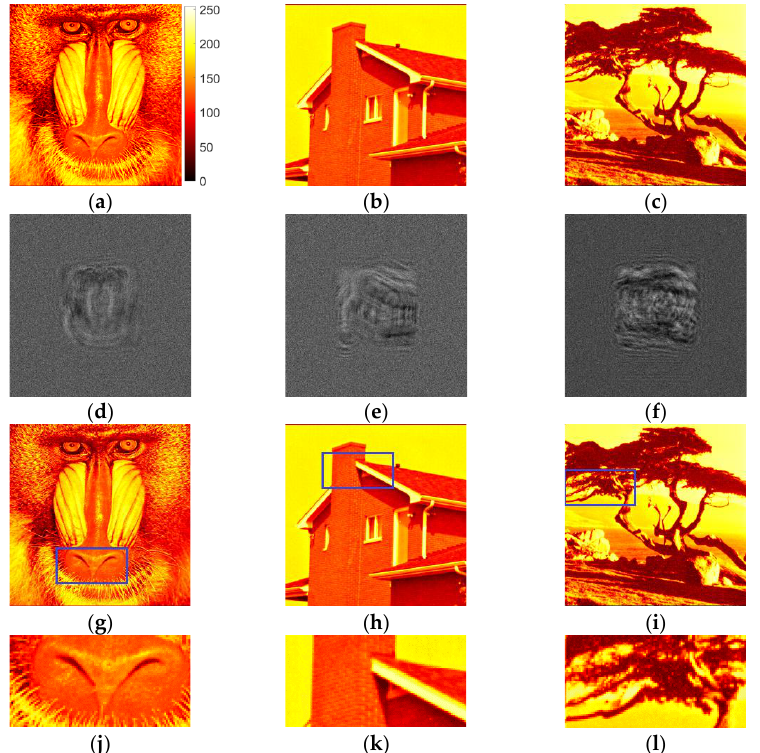
Figure 1. Test images ( a – c ), synthesized halftone amplitude inline Fresnel holograms ( d – f ), recon- structed images ( g – i ) and their enlarged fragments ( j – l ).